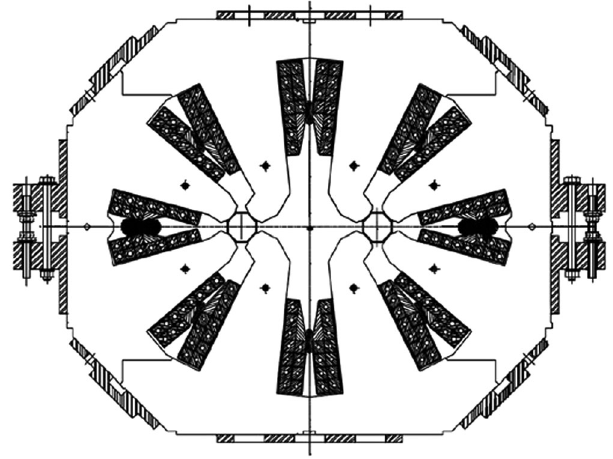
FIG. 4. Cross section of the MQW quadrupoles in